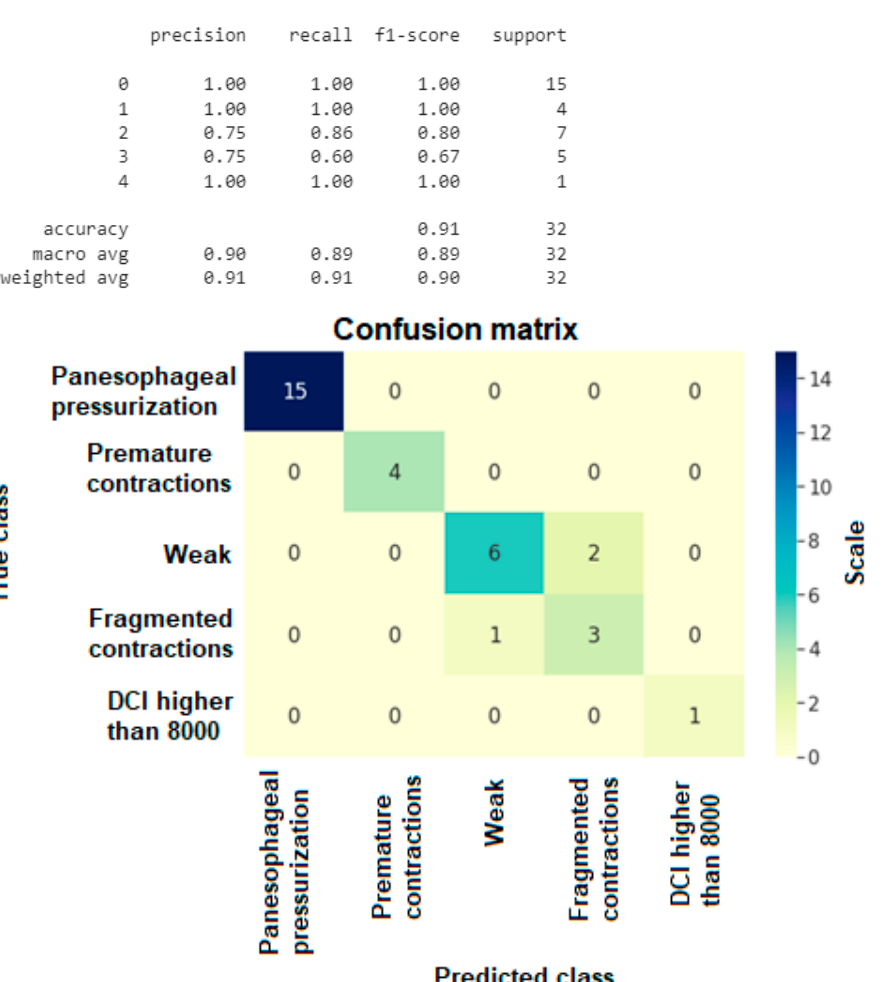
Figure 6. Swallowing pattern classification confusion matrix.